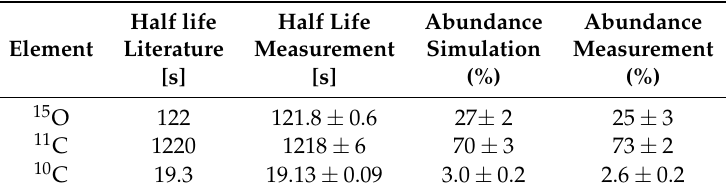
Table 2. Relative abundance and half life of the isotopes produced after proton irradiation in the Monte Carlo simulation and experimental results after fitting the measured coincidence rate. Half life Half